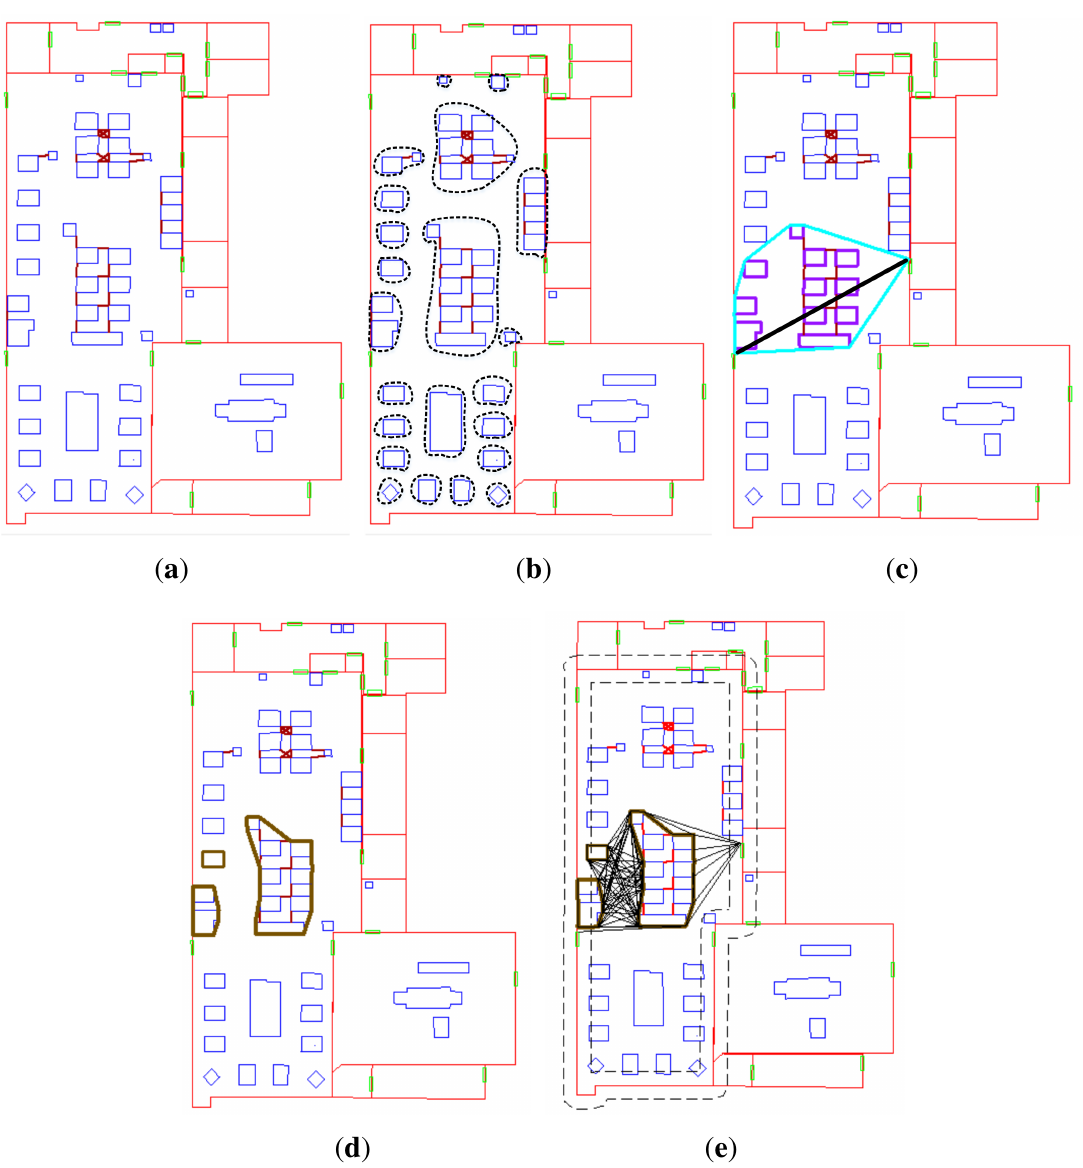
Figure 14. Testing the complete approach between two locations for a user with a size of 0.6 m. ( a ) Computing the bottlenecks between obstacles; ( b ) grouping the obstacles; ( c ) selecting obstacle groups; ( d ) creating the boundaries of the selected groups; ( e ) creating a VG and removing the inaccessible